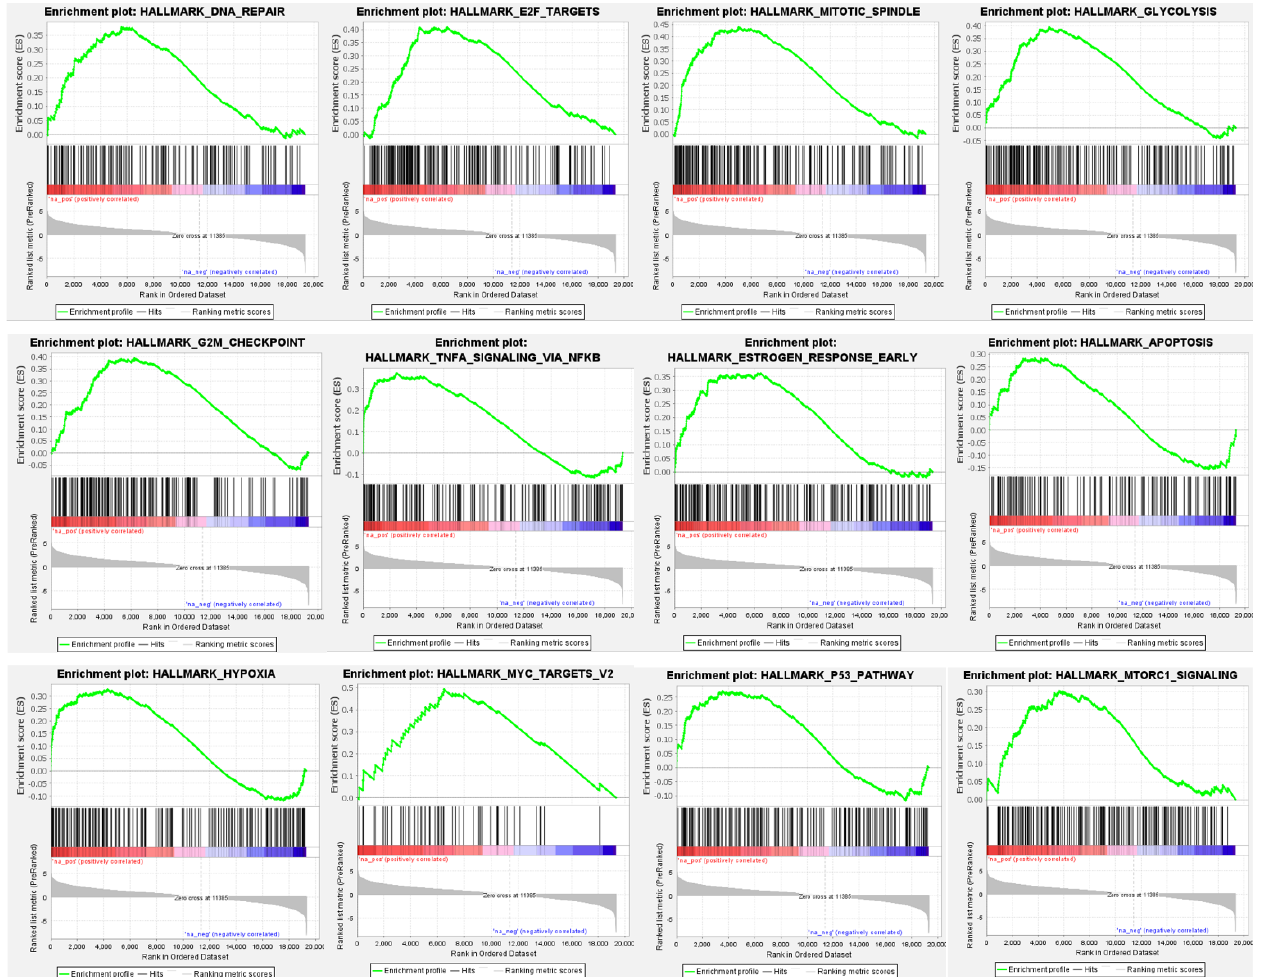
Figure 3. Gene Set Enrichment Analysis (GSEA) for RNAseq profiles between paired CNBs and surgical specimens. Examples of histograms showing the distribution of the Hallmark of cancer pathways enriched among genes showing significantly higher expression in CNBs compared with the paired surgical specimens. Refer to Supplementary Table S3 for the full list of the enriched Hallmark of cancer pathways among the genes with higher expression in CNBs compared with surgical specimens.